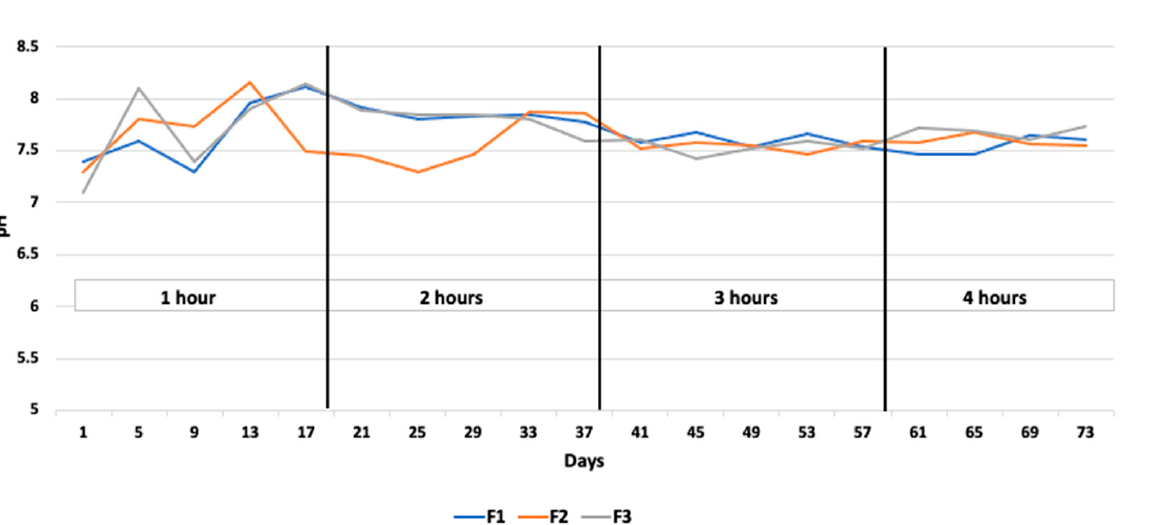
Figure 6. VFA concentration at various mixing regimes.